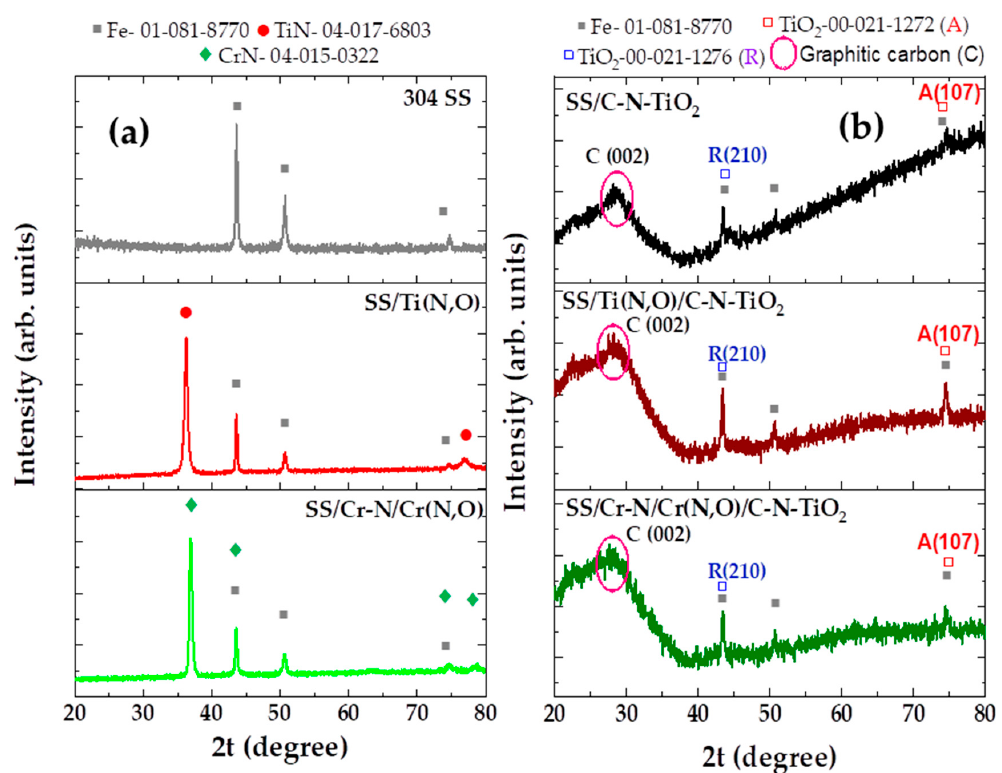
Figure 4. X-ray diffraction (XRD) patterns of : ( a ) 304 SS, SS coated with Ti(N,O) and Cr-N/Cr(N,O); ( b ) C-N-TiO 2 catalysts coated on SS, SS/Ti(N,O) and SS/Cr-N/Cr(N,O) (pyrolysed at 350 °C, ramping rate 50 °C/min, holding times of 105 min); SS = stainless steel, A = anatase and R = rutile.